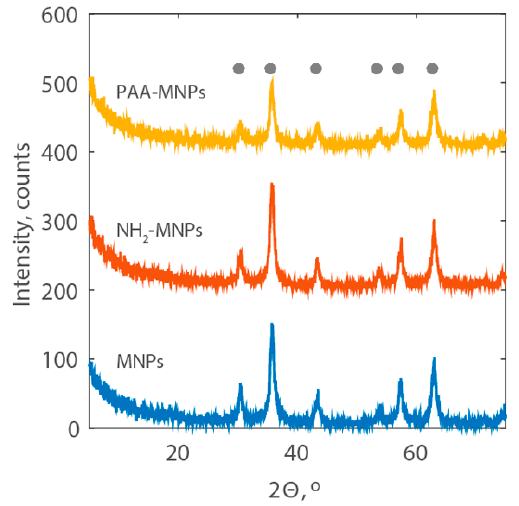
Figure 4. XRD patterns of MNPs, NH 2 -MNPs, and PAA-MNPs with the location of the peaks of the reference magnetite (grey dots).